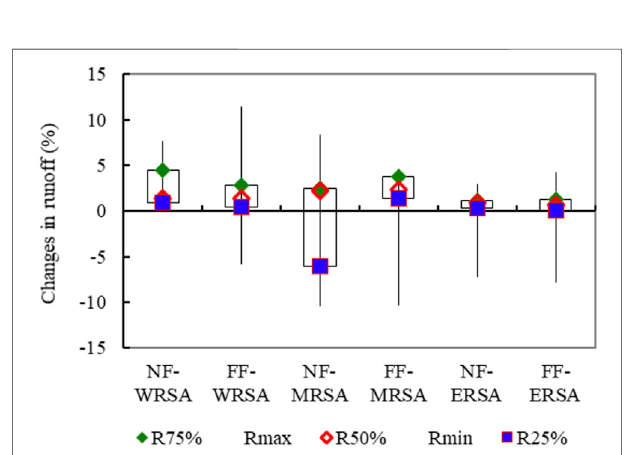
FIGURE 7 | Runoff changes in two periods of near future (NF) and far future (FF) relative to the baseline period of 1956 – 2000 for all three source areas of the South-to-North Water Diversion